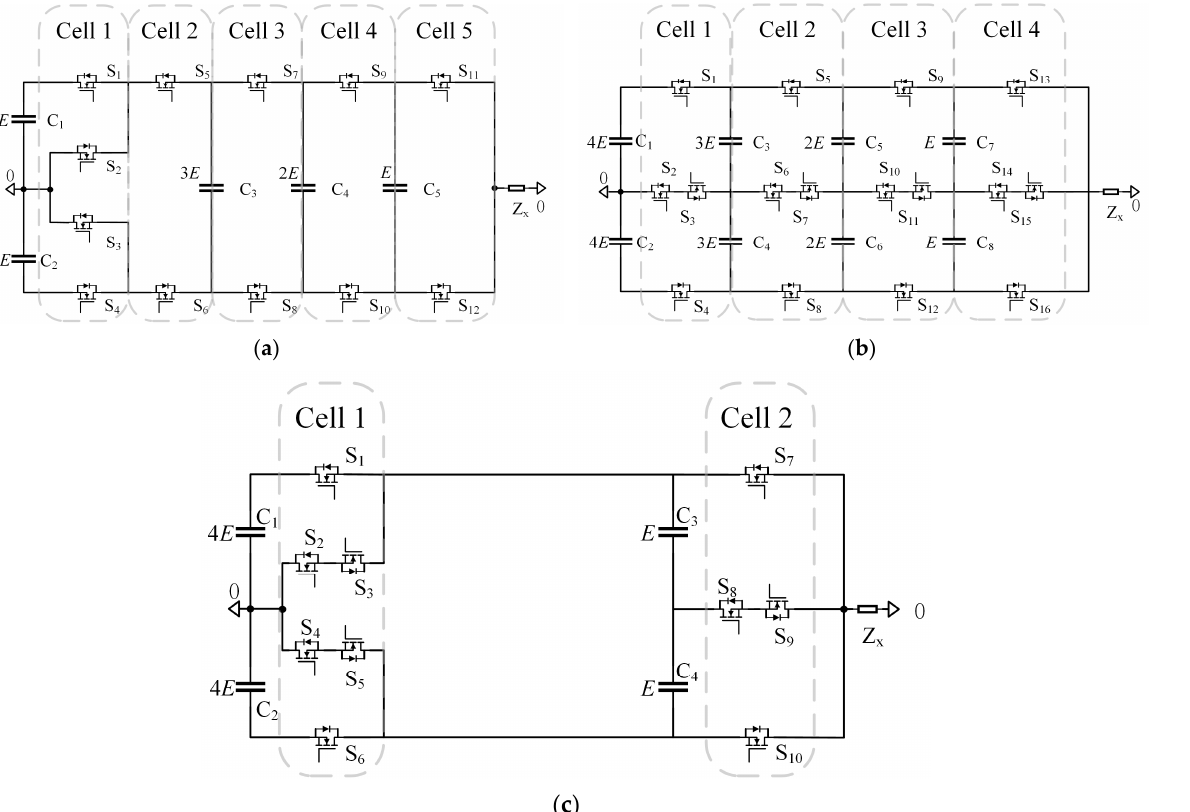
Figure 2. Operating states of the proposed 9-level topology. ( a ) V O = 4 E ; ( b ) V O = 3 E ; ( c ) V O = 2 E ; ( d ) V O = 2 E ; ( e ) V O = E ; ( f ) V O = 0; ( g ) V O = 0; ( h ) V O = − E ; ( i ) V O = − 2 E ; ( j ) V O = − 2 E ; ( k ) V O = − 3 E ; ( l ) V O = − 4 E.